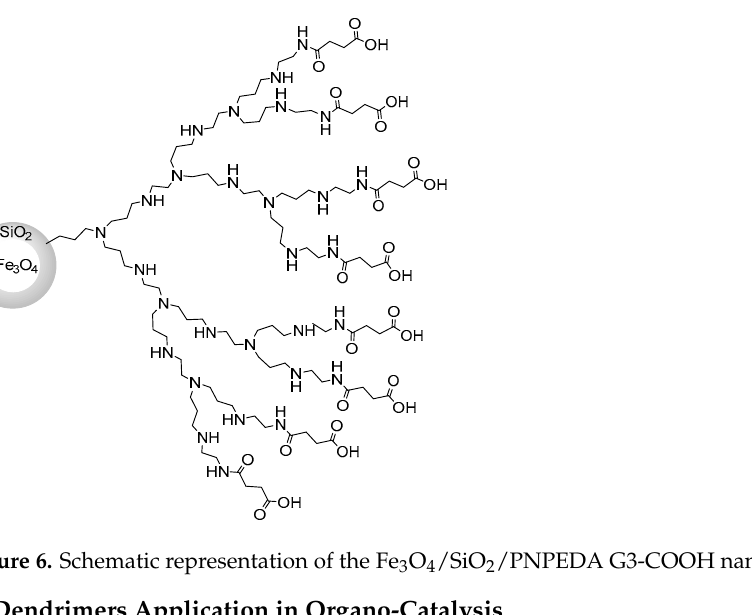
Figure 6. Schematic representation of the Fe 3 O 4 /SiO 2 /PNPEDA G3-COOH nanomaterial.